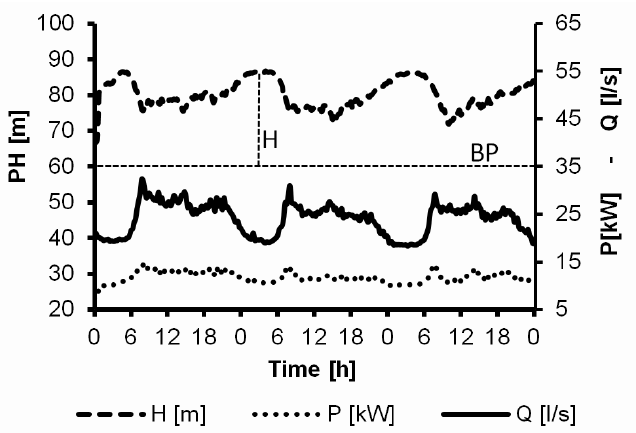
Figure 3. Pressure head, flow rate variations and